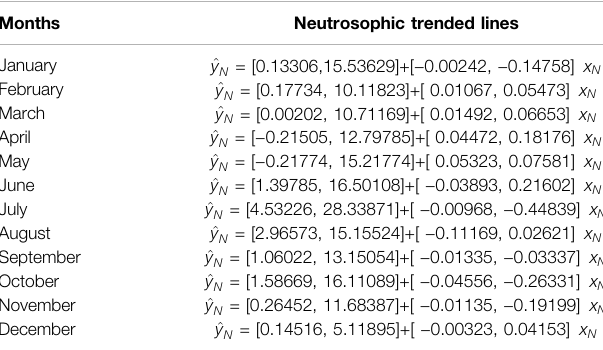
TABLE 1 | Neutrosophic trended lines of wind speed data of